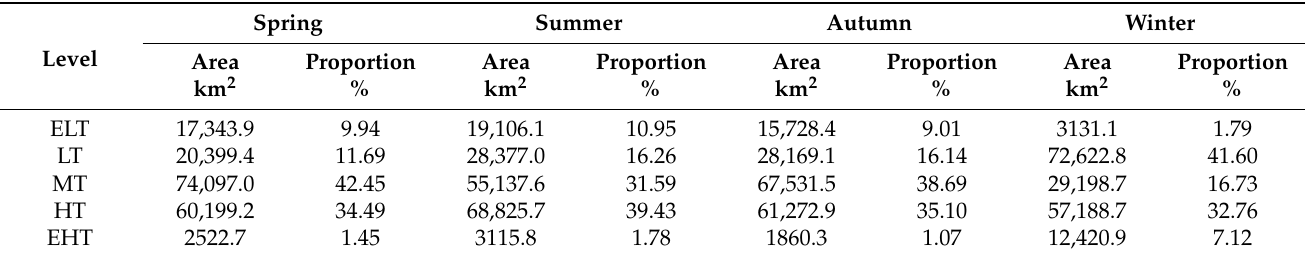
Table 2. Area of each grade of LST and its proportion.